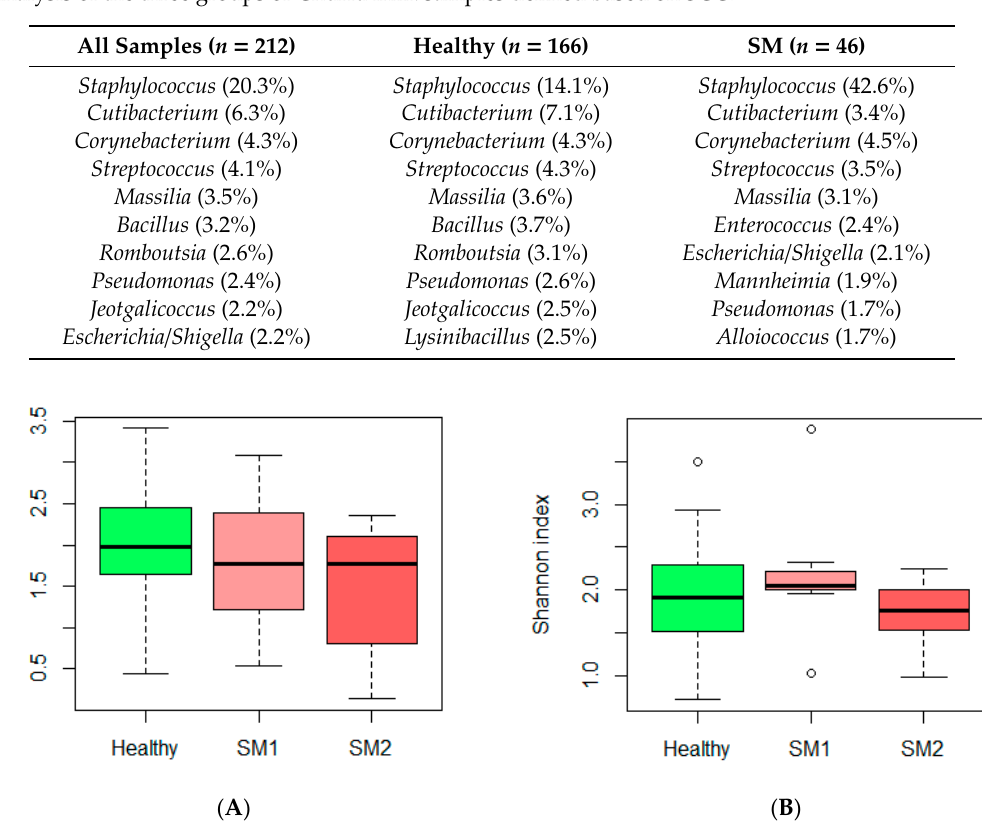
Table 2. Relative microbial abundances for the 10 top-most abundant genera identified by the microbiota analysis of the three groups of Churra milk samples defined based on SCC.